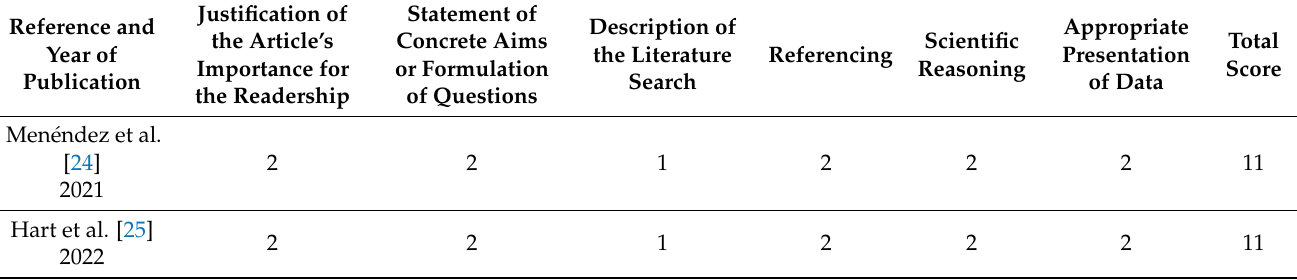
Table 1. SANRA Score for quality assessment of selected studies for the review.